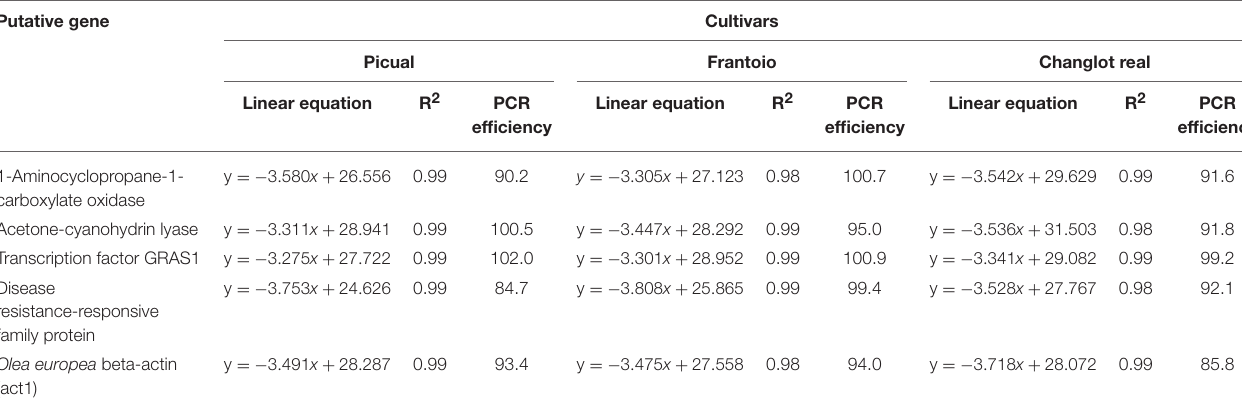
TABLE 2 | List of selected transcripts induced in olive aerial tissues upon Verticillium dahliae colonization used in qRT-PCR experiments with susceptible (Picual) and tolerant (Frantoio and Changlot Real) olive cultivars. Putative